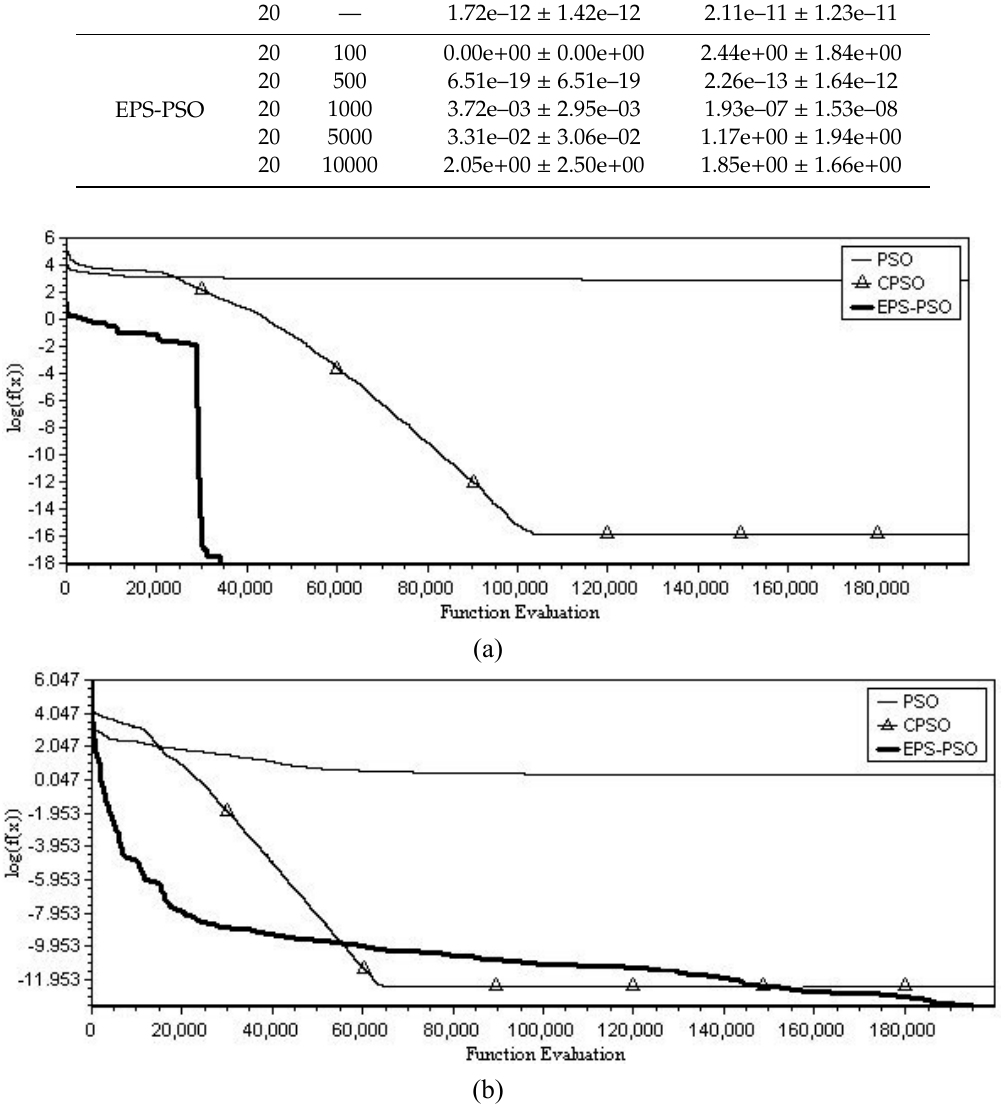
Figure 5. The best convergence results versus function evaluation among 50 independent runs for Ackley ( f 3 ): ( a ) unrotated case, ( b ) rotated